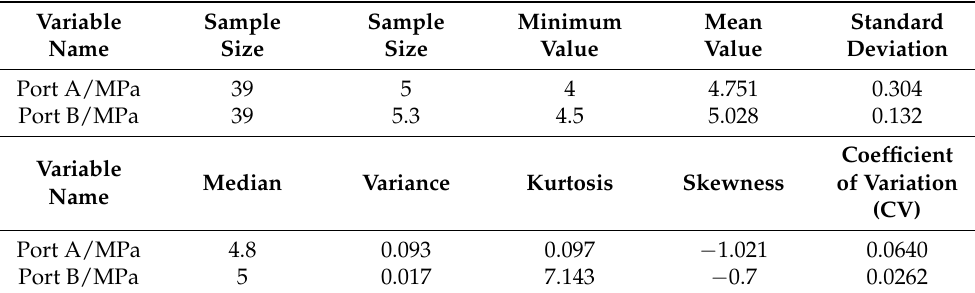
Table 2. Results of descriptive statistics of power oil pressure after 12,000 fatigue